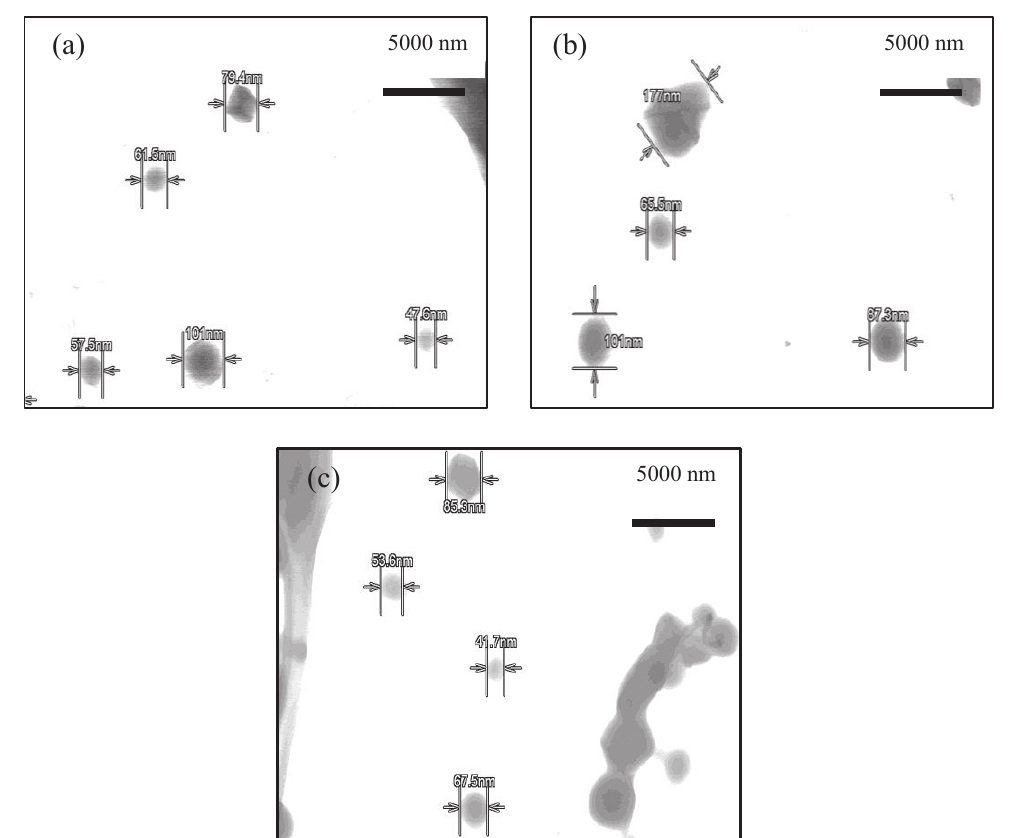
Figure 5: TEM images of (a) NOOSC, (b) NONSC and (c) NOOGC at 100,000x magnifications.